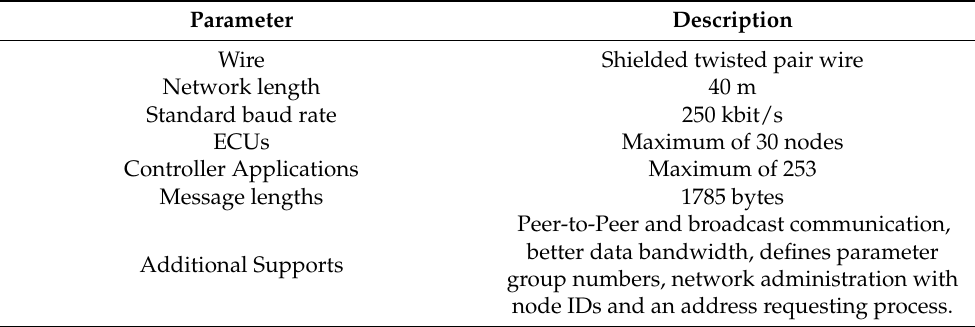
Table 1. SAE J1939 Specifications and Features [19].